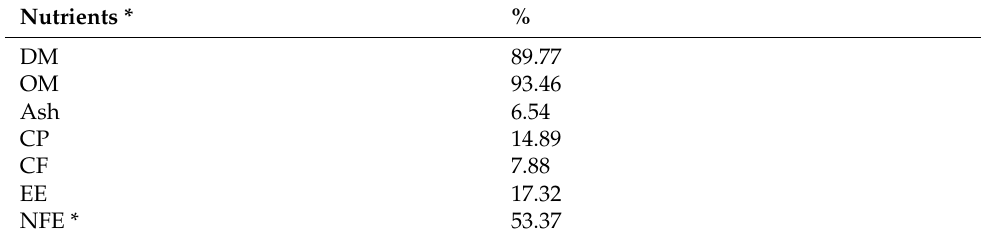
Table 1. Nutrient composition of rice